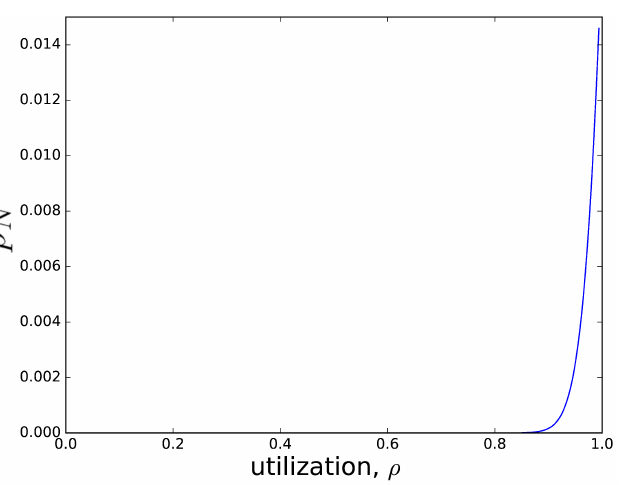
Figure 3. Density f R ( t ) of the queueing time; see Equation (8).